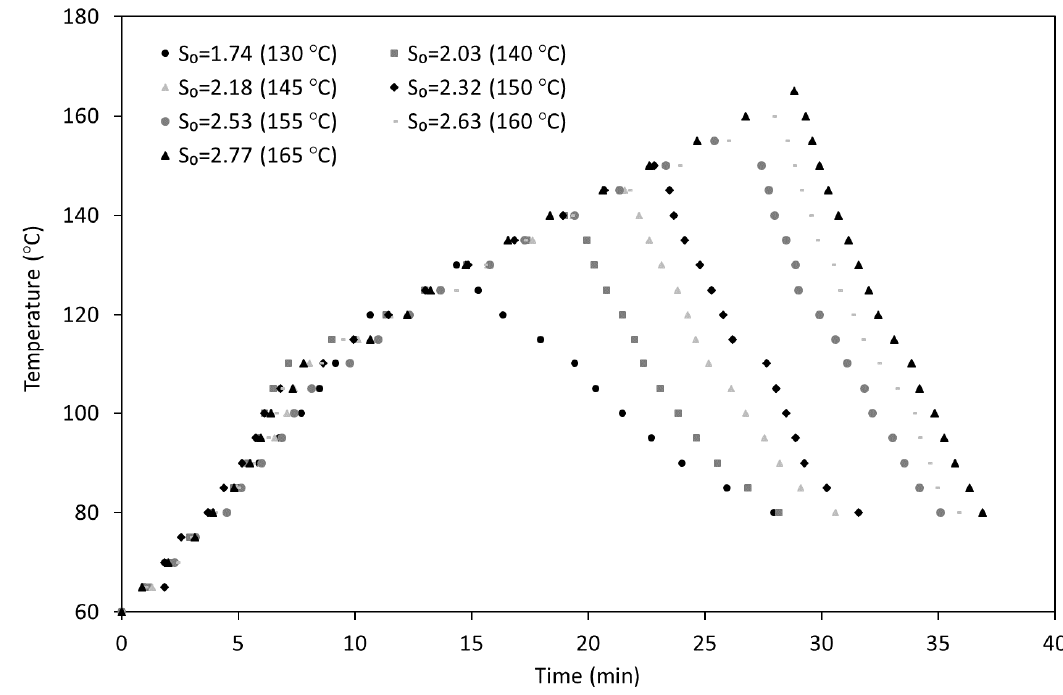
Figure 1. Heating and cooling temperature profiles determined for the autohydrolysis experiments carried out at all conditions assayed.